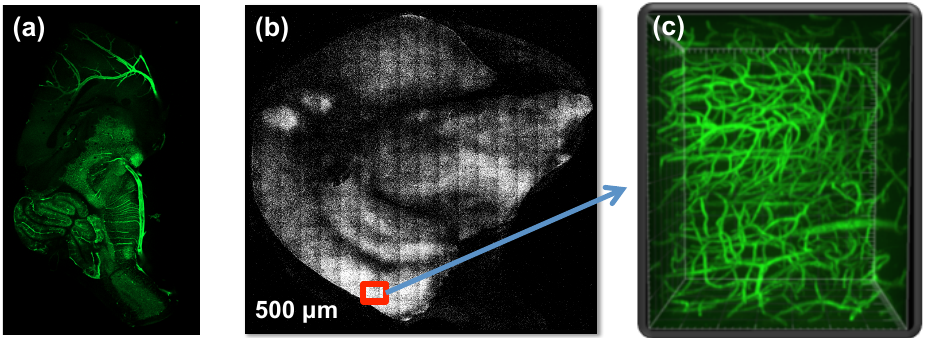
Figure 2. Tissue staining: The tissue was divided in cubic samples of 500 µ m: ( a ) endothelial labeling with lectin; ( b ) cubic samples; ( c ) close-up view of the single cubic sample box in red in ( b ). From the cubic samples represented in Figure 2b (a single region is highlighted in red), five cortical regions were selected and further used for images acquisition,